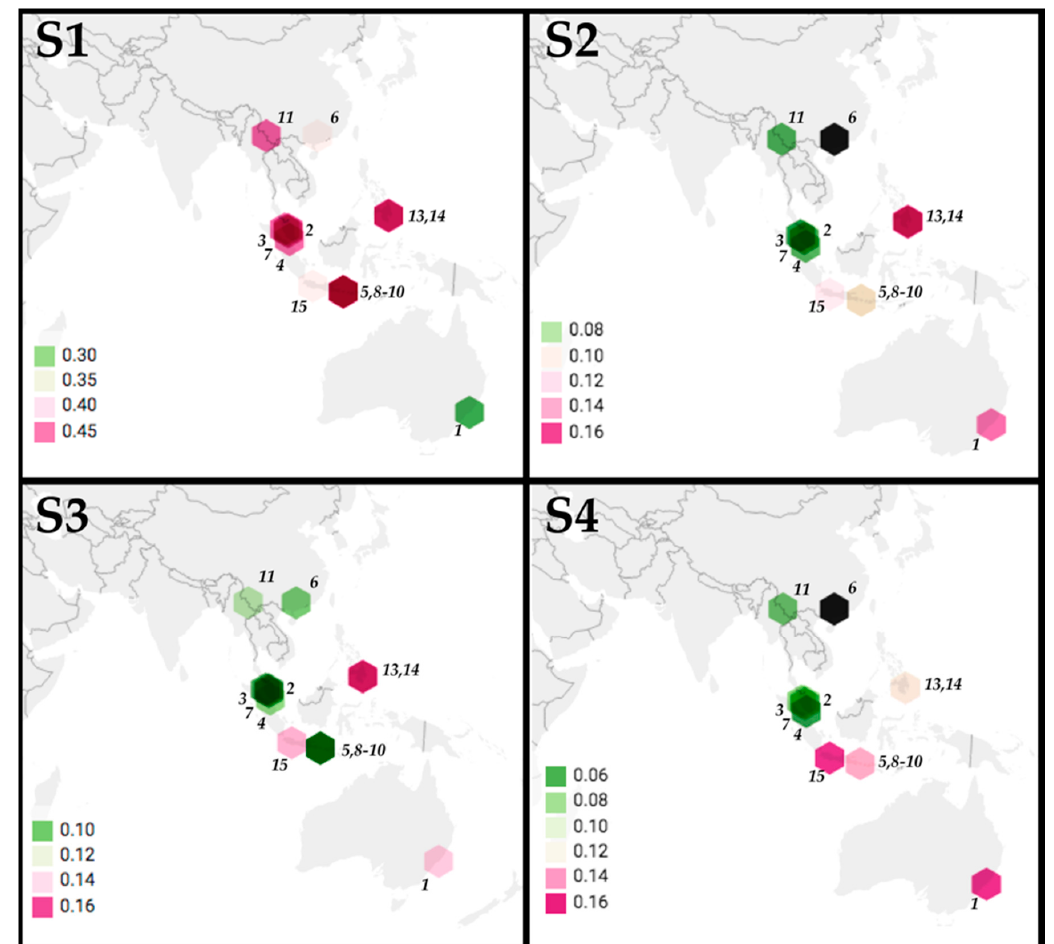
Figure 3. Phylogeographic analysis of PRV segments S1-S4. The p-distances between PRV16K segments S1-4 and segments S1-S4 of 14 PRV isolates (MEGA7, 1000 bootstrap replicates) are indicated by hexagons indicating the locations of origin of PRV isolates, with hexagons colored to indicate p-distance values (scale bars indicate ranges for each segment). The numbers indicate PRV isolate: (1) PRV1NB, (2) PRV2P, (3) PRV3M, (4) PRV4K, (5) PRV5HK, (6) PRV6XR, (7) PRV7S, (8) PRV8B, (9) PRV9HK, (10) PRV10M, (11) PRV11C, (12) PRV12I, (13) PRV13P, (14) PRV14P, (15) PRV15G. The GenBank accession numbers are in Supplemental Table S1. The sequences for S2 and S4 were not available for (6) PRV6XR (indicated by a black hexagon). Table 2. Mantel test showing the correlation of geographic and genetic distances for PRV S1, S2, and S4. PRV Genome Segment Virus